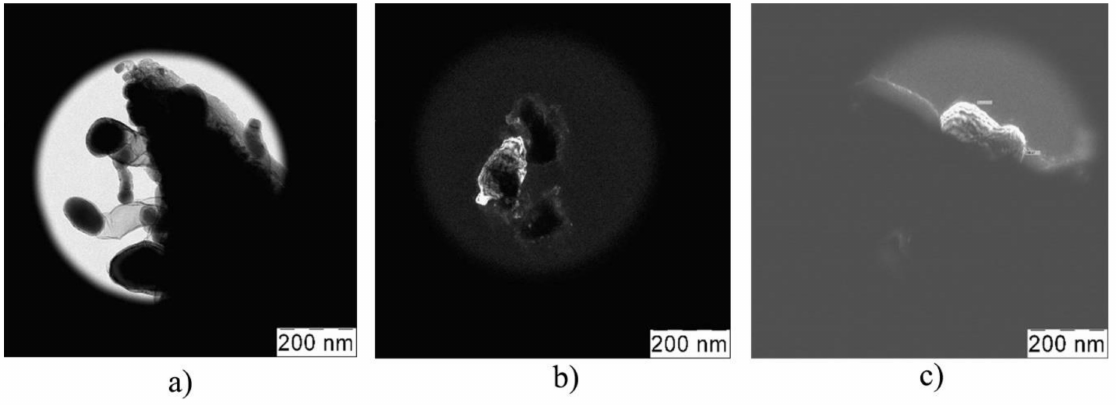
Figure 3. TEM images of iron samples: Fe(n–Fe 2 O 3 _01) ( a ); Fe(n–Fe(OH) 3 ) ( b );Fe(n–FeO_01) ( c ). Fe(n-FeOOH), Fe(n–Fe 2 O 3 _02), and Fe(n-FeO_02) samples consisted of fine particles with a size of no more than 30 µ m (see Figure 4). Fe(n–FeOOH) sample consisted of agglomerated iron nanoparticles with an average size of less than 1 µ m. The Fe(n–Fe 2 O 3 _02) sample was characterized by a spherical particle shape and an average size of no more than 3 µ m. The Fe(n-Fe_02) sample consisted of larger irregularly shaped particles with an average size of 20–30 µ